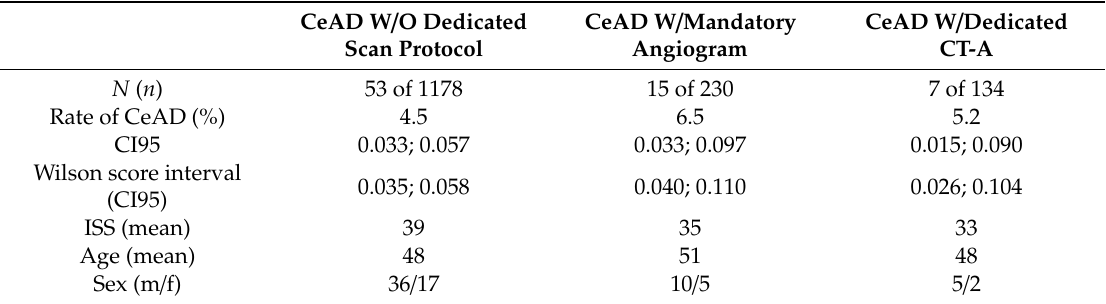
Table 1. Cohort characteristics depending on the diagnostic approach for the detection of cervical artery dissections (CeAD). CeAD W / O Dedicated CeAD W / Mandatory CeAD W / Dedicated Scan Protocol Angiogram CT-A N ( n ) 53 of